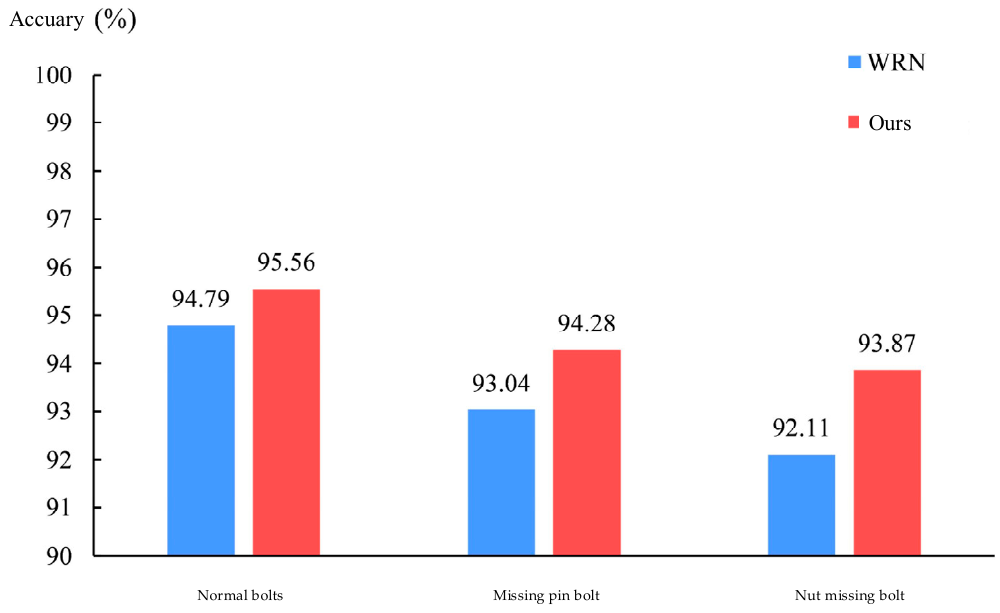
Figure 9. Comparison of classification accuracy before and after model improvement.